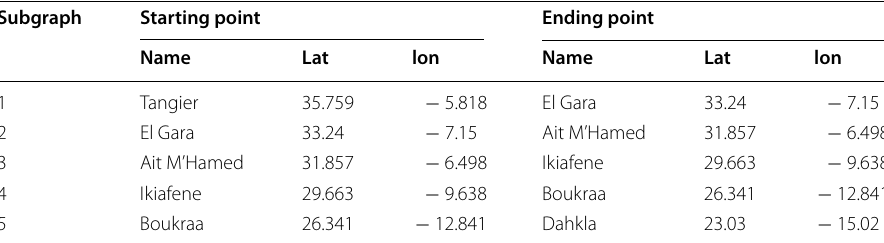
Table 2 Subgraph boundaries